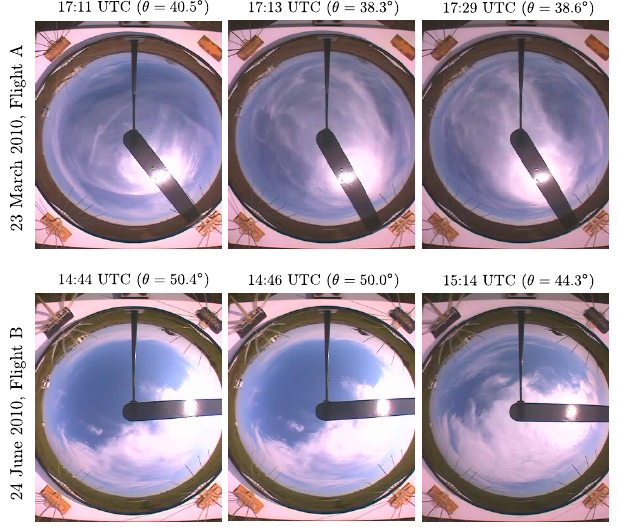
Figure 12. Cloud scenes based on the total sky imager (TSI) located at the SGP site. Images are shown for the six times corresponding to the times of SAM measurements used in the comparison with simulations (see Tables 4 and 5).